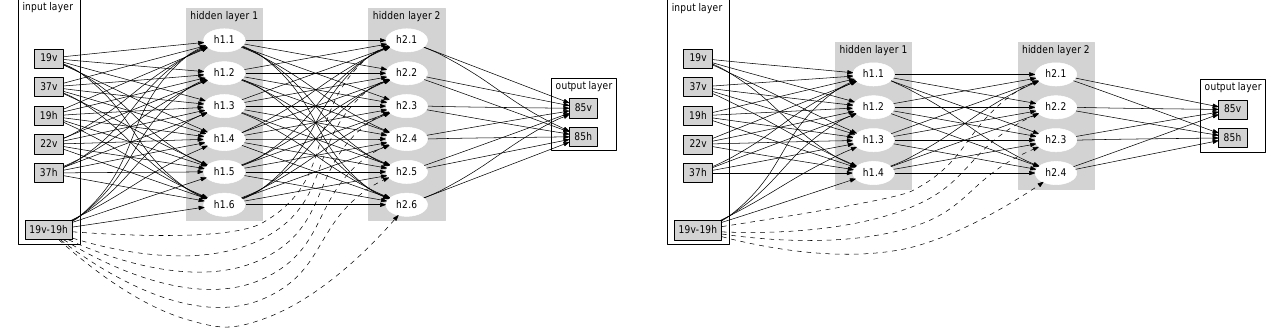
Figure 8. Neural network architectures of the 85GHz synthesis algorithm. The left neural network with six neurons in each layer is used for the rain-free and calm situations. The network shown in the right panel is used for cases with high winds and precipitation.